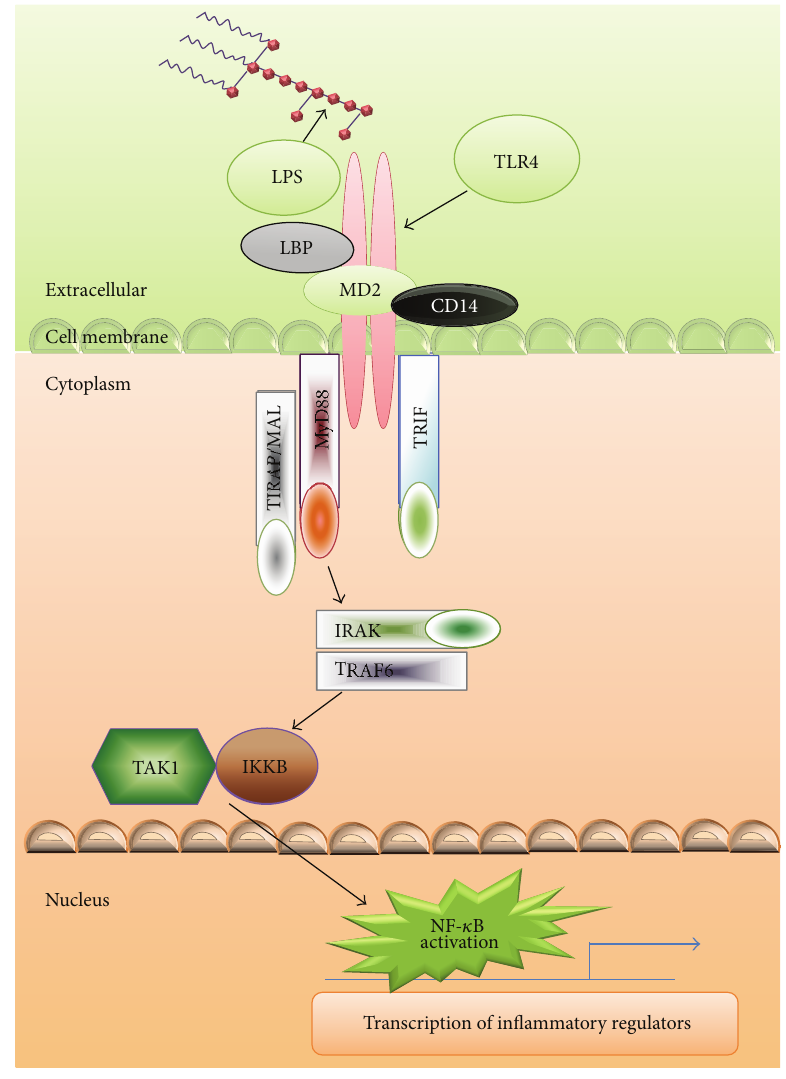
Figure 2: TLR4 signaling during the host-pathogen interaction: pattern recognition receptors (PRRs) recognize evolutionary conserved repetitive structures such as lipid A in LPS present in Campylobacter jejuni and various other microorganisms. Stimulation of TLR4 by LPS facilitates the activation of two pathways: the MyD88- (myeloid differentiation primary-response protein 88-) dependent and MyD88- independent pathways (not shown). Downstream of TLR4 signaling involves different types of adaptor molecules which depend on the type of LPS and result in early phase of NF- 𝜅 B activation, which leads to the production of inflammatory cytokines. LPS, lipopolysaccharide; LBP, lipopolysaccharide binding protein; TLR4, toll-like receptor 4; MAL, MyD88 adaptor-like; TRIF, TIR domain-containing adaptor-inducing IFN- 𝛽 ; TRAF, TNF receptor-associated factors; TIRAP, toll-interleukin 1 receptor (TIR) domain-containing adaptor protein; IRAK, IL-1 receptor-associated kinase; TAK, TGF 𝛽 -activated kinase; IKKB, I 𝜅 B kinases; NF- 𝜅 B, nuclear factor kappa-light-chain-enhancer of activated B